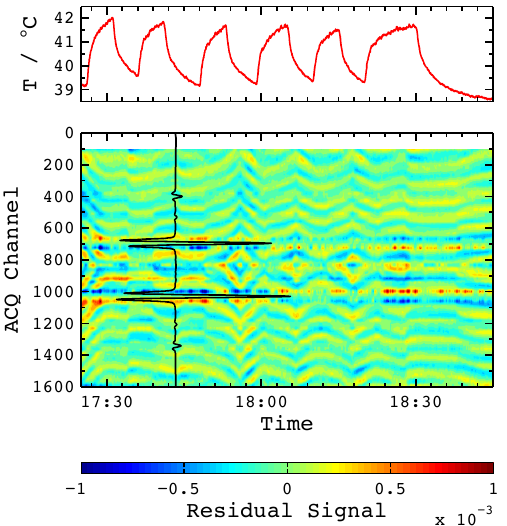
Figure 5. (a) Temperature recording of the mount of the f = Fig. 5: (a) Temperature recording of the mount of the f = 25 . 4mm collection lens. (b) Array of spectral residuals recorded in 25 . 4 mm collection lens. (b) Array of spectral residuals the laboratory while repeatedly modulating the temperature of the recorded in the laboratory while repeatedly modulating the f = 25 . 4mm collection lens. The color code represents the resid- temperature of the f = 25 . 4 mm collection lens. The color ual amplitude scaled to optical density. The black trace depicts a code represents the residual amplitude scaled to optical den- second-harmonic spectrum recorded at 1s integration sity. The black trace depicts a second-harmonic spectrum recorded at 1 s integration time.